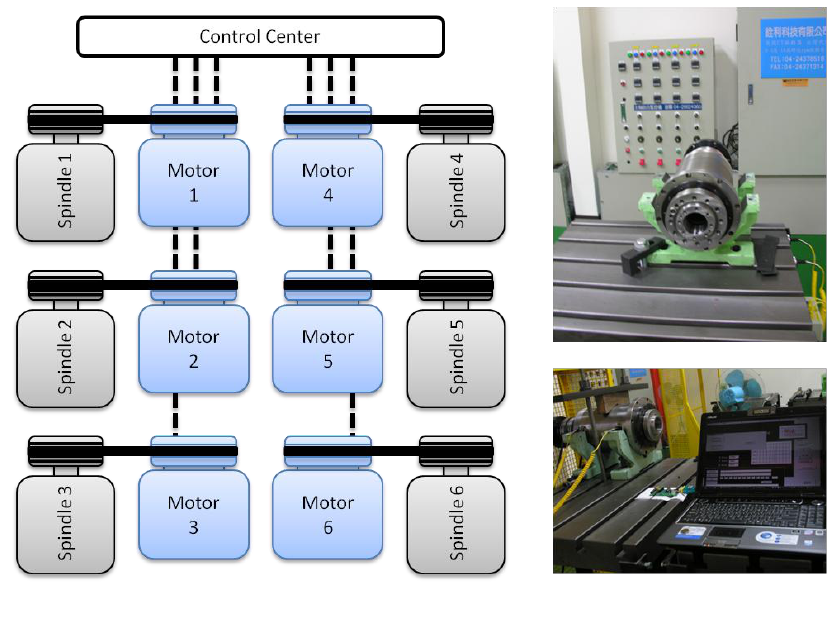
Figure 6. The running-in test system in the spindle production